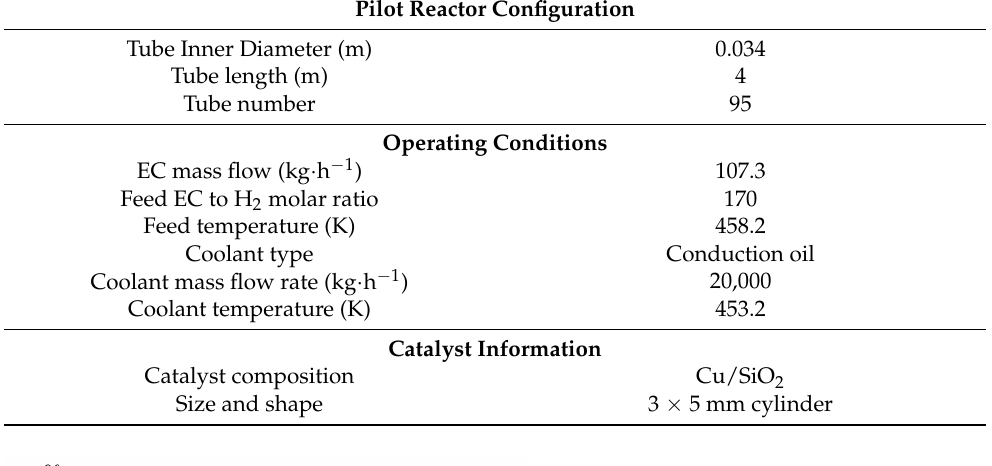
Table 3. Structure and working conditions of the pilot reactor for EC hydrogenation.